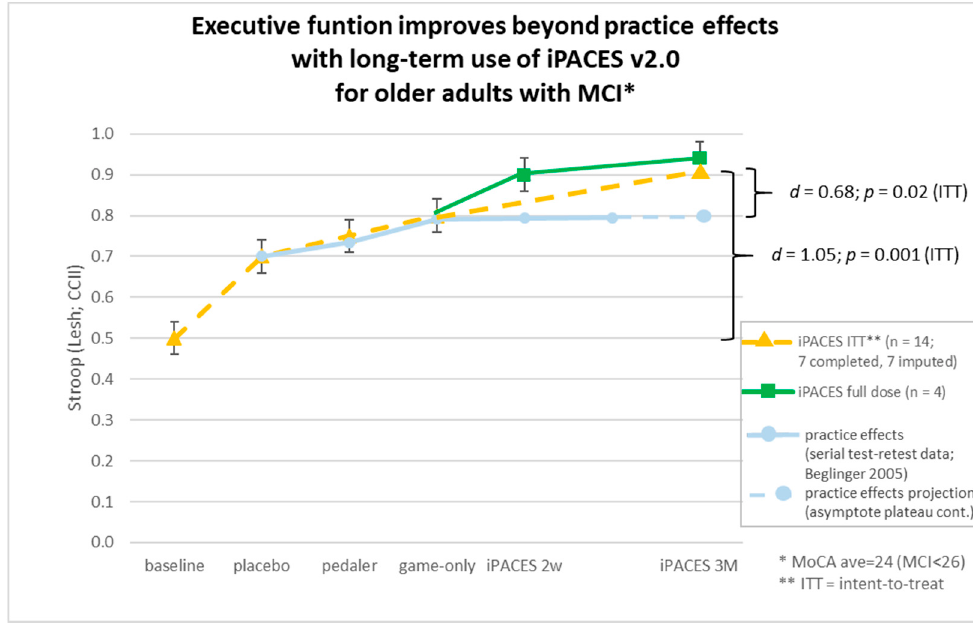
Figure 4. Changes in cognition over three-month iPACES neuro-exergame intervention exceed practice effects.